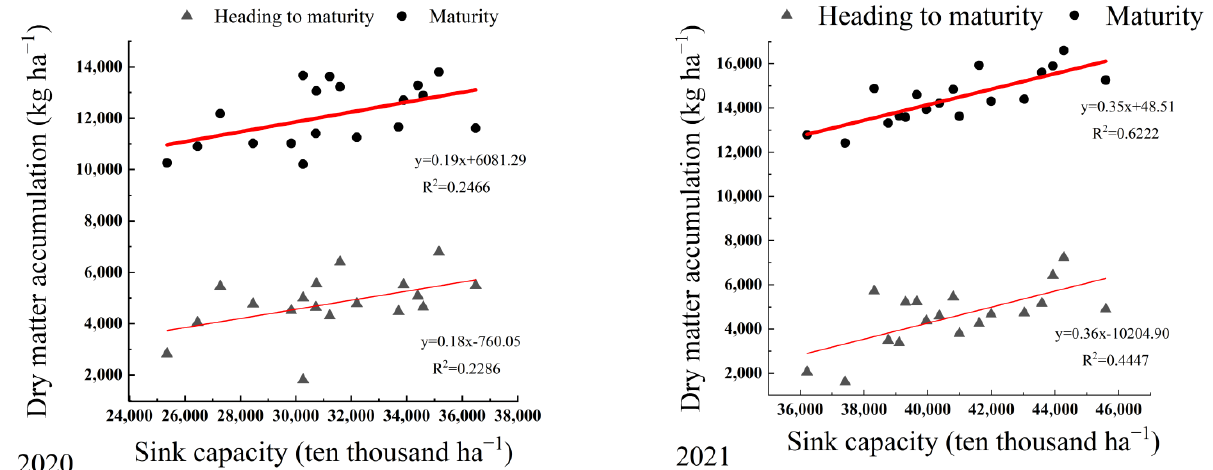
Figure 4. Relationship between sink capacity and dry matter accumulation in rice. Correlation analysis showed that the sink capacity was significantly positively cor- related with the leaf nitrogen content (r = 0.71 **) and nitrogen accumulation (r = 0.71 **) and (r = − 0.50 *) and nitrogen harvest index (r = − 0.54 *) in 2021. However, no significant correla- tions were found in 2020 (Table 7.). Table 7. Correlation analysis between rice sink capacity and nitrogen accumulation and utiliza- tion.